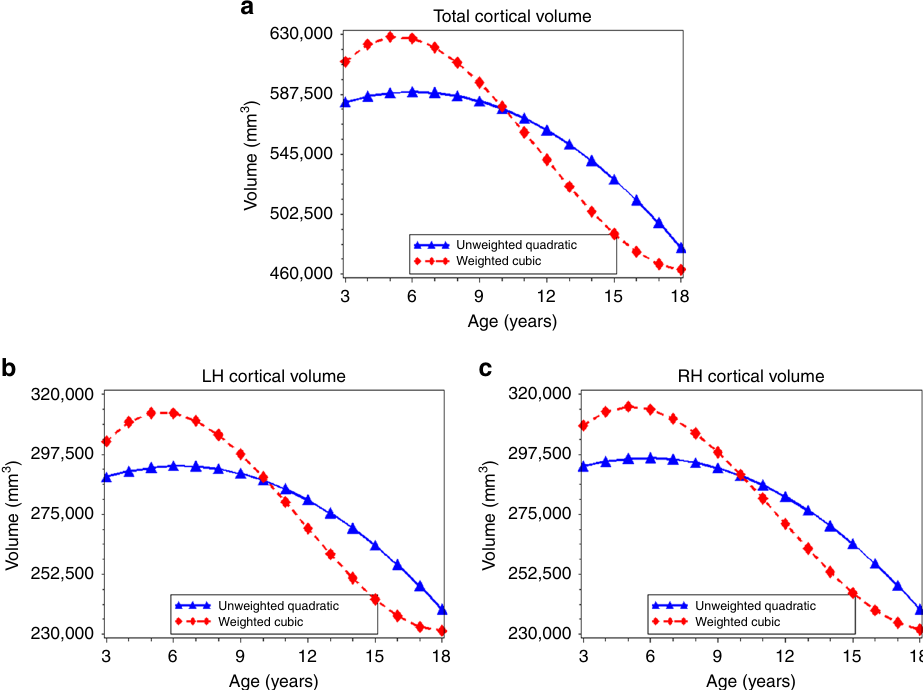
Fig. 1 Age-related variation in cortical volume. Using the best- fi tting regression models described in Table 2, we calculated the predicted values by age for total cortical volume ( a ), left hemispheric cortical volume ( b ), and right hemispheric cortical volume ( c ) in the unweighted ( blue lines ) and weighed ( red lines ) samples. LH left hemisphere, RH right